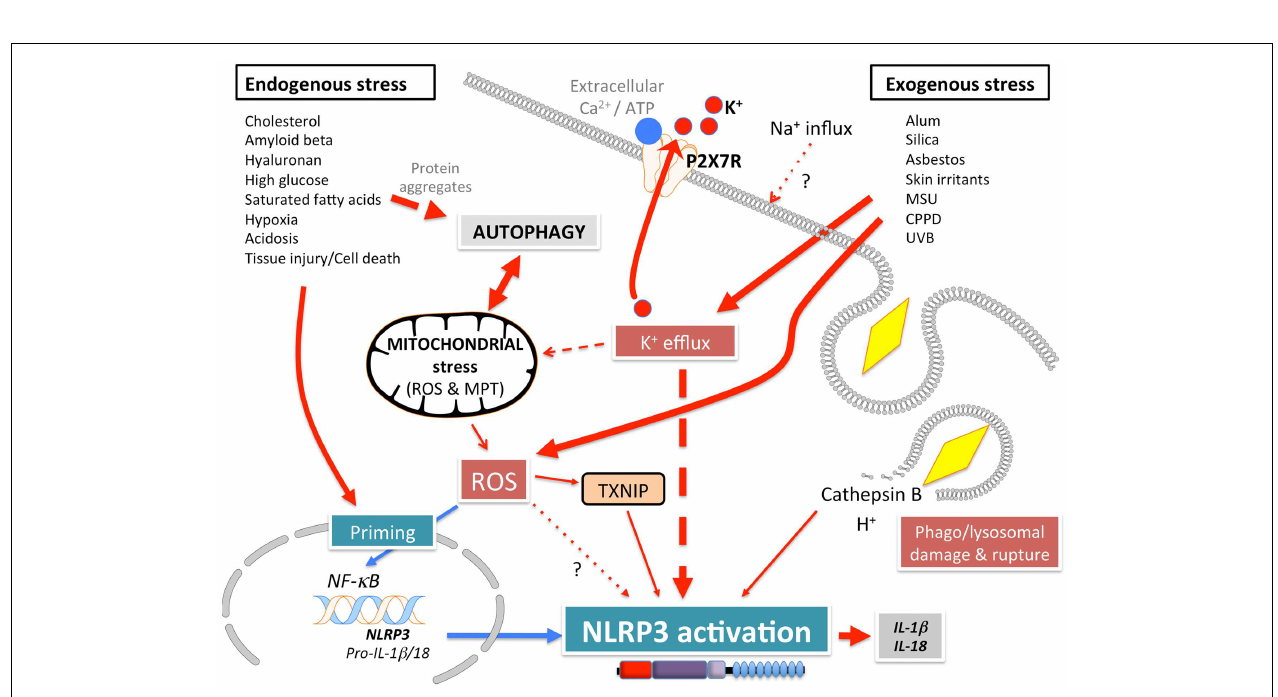
FIGURE 3 | Mechanism of NLRP3 activation in response to pathogen infection .